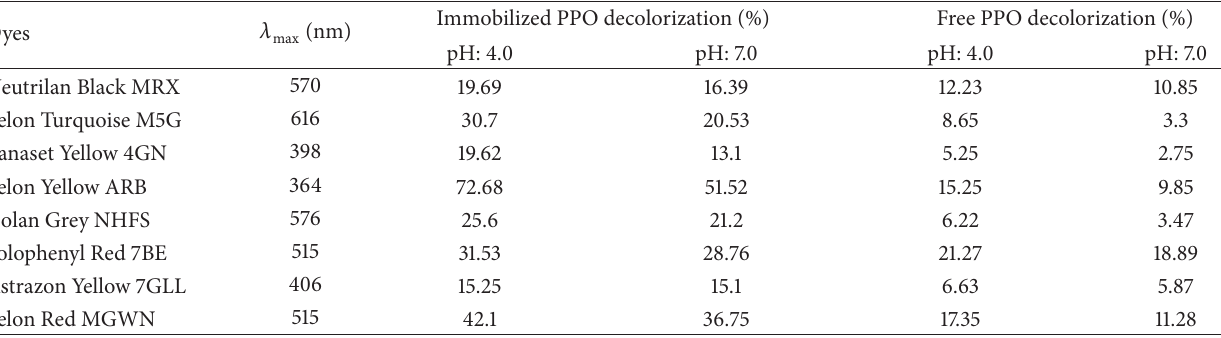
Table 1: Decolorization of textile dyes by quince leaf